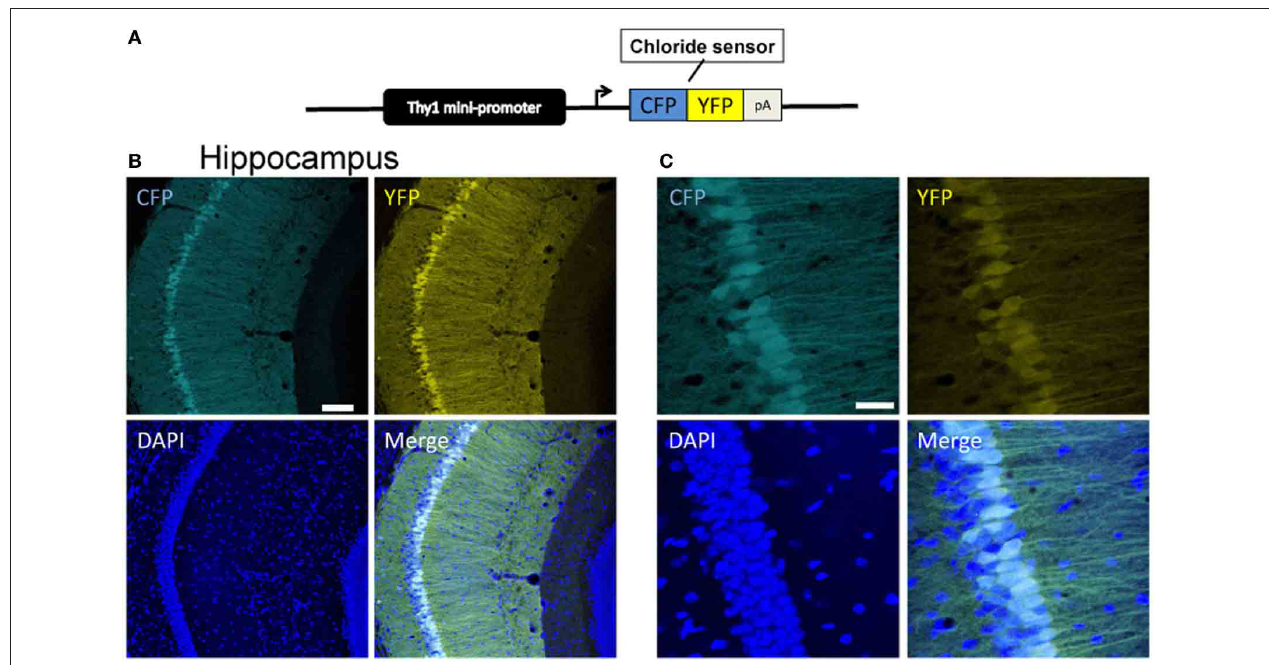
Thy1 ::Cl-Sensor transgenic mouse showing CFP (upper left), YFP (upper right), and DAPI (lower left), and merged (lower right) fluorescence at (B) 20 × magnification, scale bar corresponds to 30 μ m and (C) 40 × magnification, scale bar corresponds to 100 μ m. Cl-Sensor expression was found in a mosaic pattern in most, but not all CA1 pyramidal